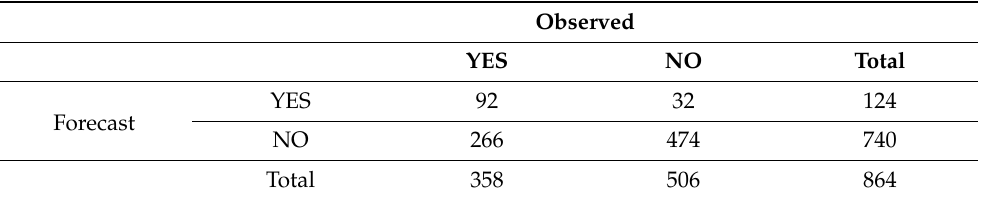
Table 7. Results of the indexes calculated for forecasted and observed precipitation accumulated during the period of 10 June–31 October 2010.